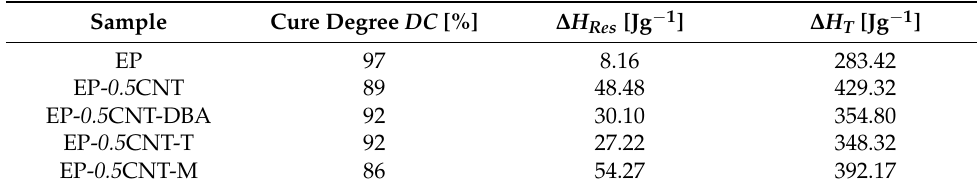
Table 2. DSC data of the cured